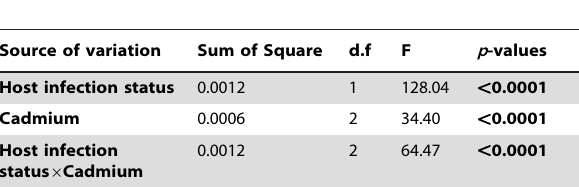
Table 2. ANOVA for the effects of host infection status and cadmium on the P. minutus malondialdehyde level.